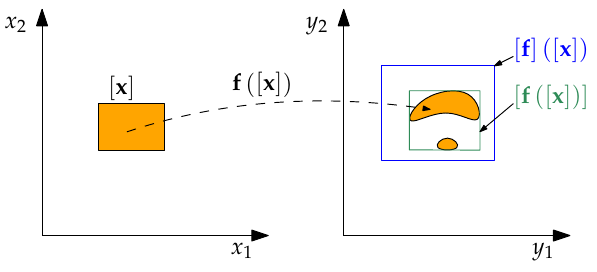
Figure 3. Types of inclusion functions.